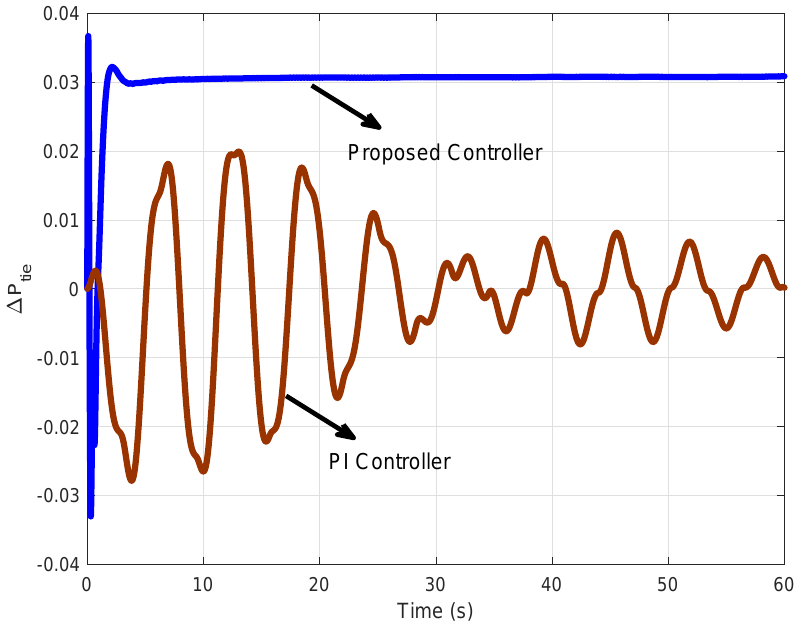
Figure 13. Deviation of the tie-line power with the proposed and PI